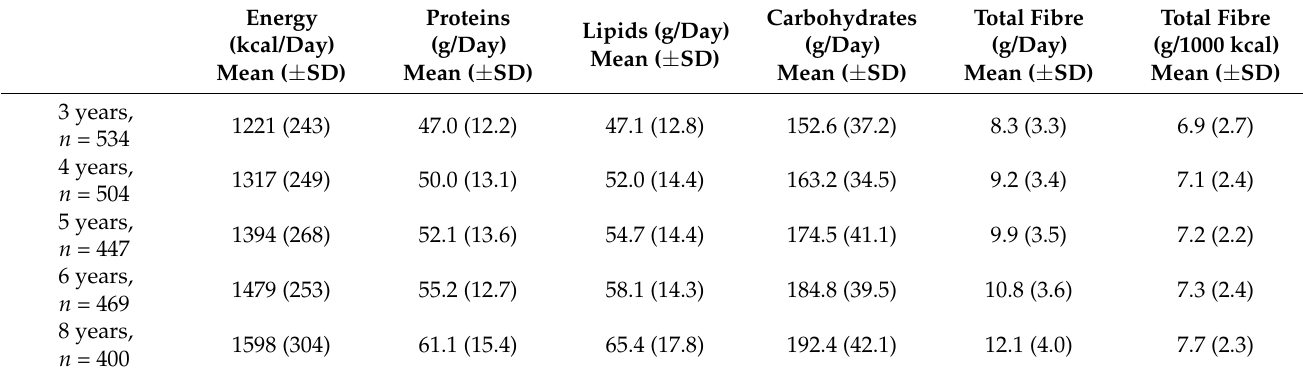
Table 1. Energy, macronutrient and fibre intakes by age